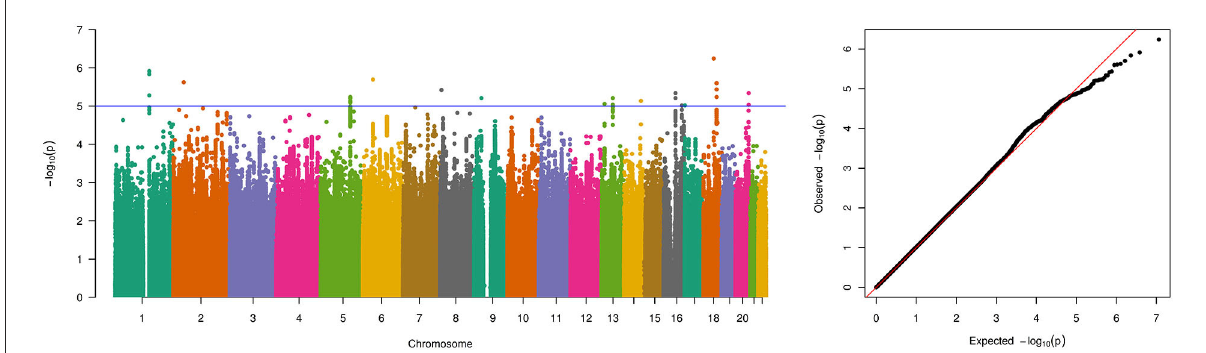
FIGURE1 Manhattan and quantile-quantile (QQ)-plot of pooled genome-wide association study results for the 5,754,208 variants that were genotyped and passed quality control in all 4 PUV cohorts for a total number of 756 patients and 4,823 controls. The blue line indicates the threshold for suggestive genome-wide significance ( p -value of 1 × 10 − 5 ).